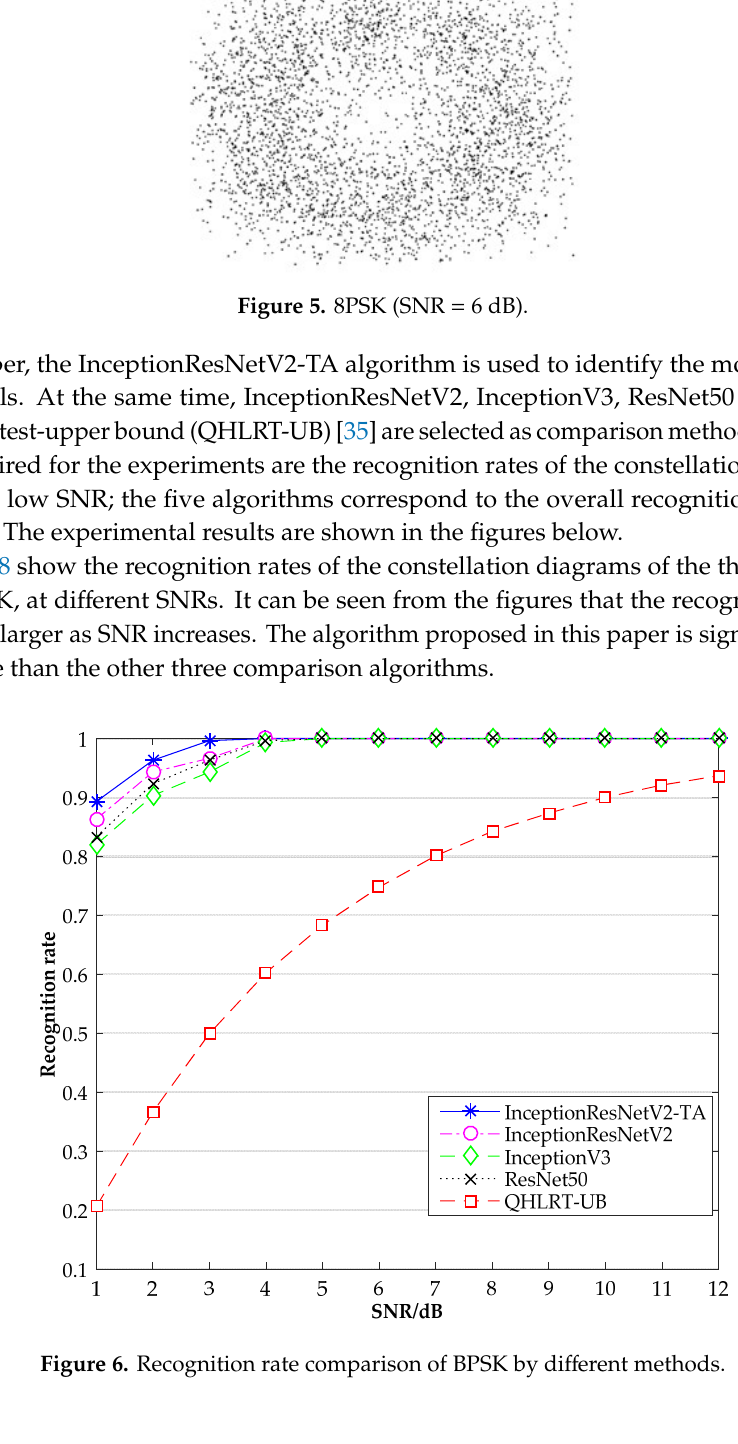
Figure 4. QPSK( SNR = 6 dB)